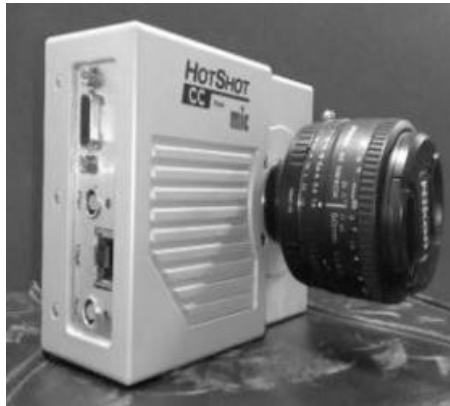
Figure 6. High-speed camera.